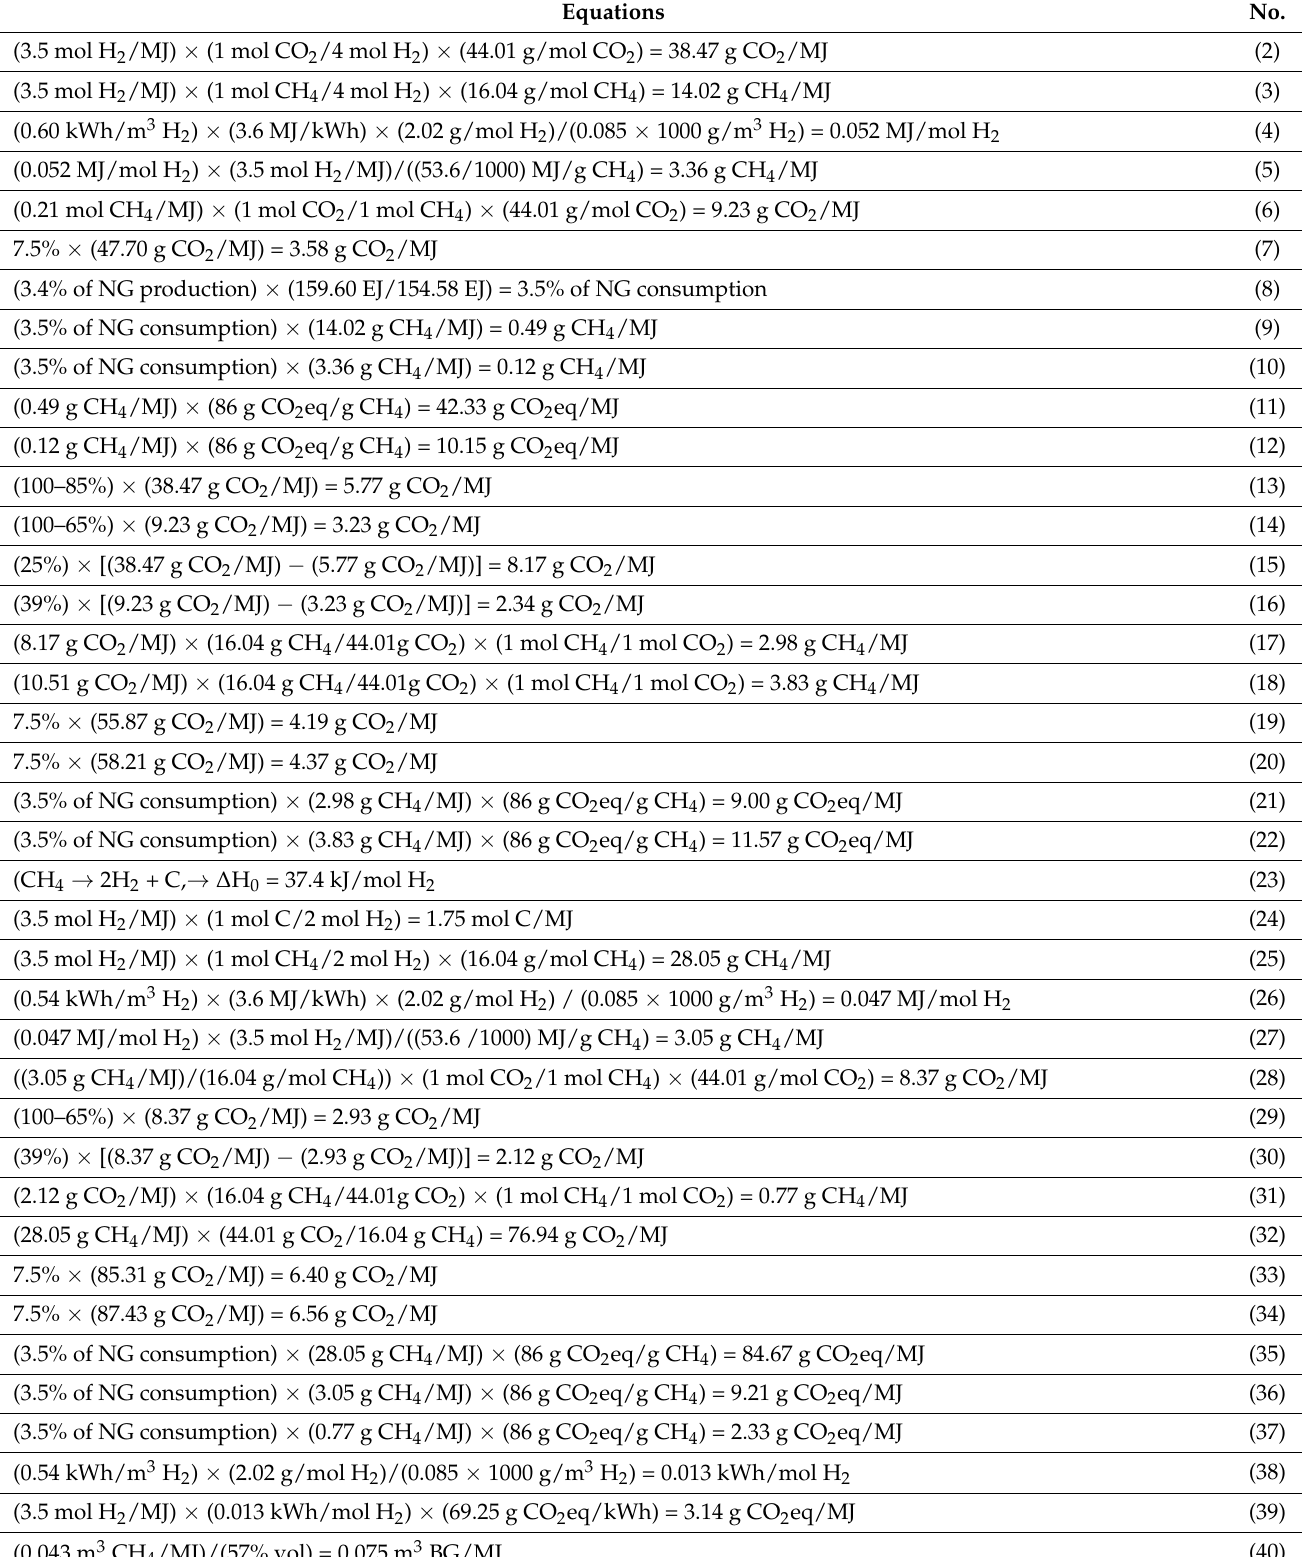
Table 3. Table of equations.